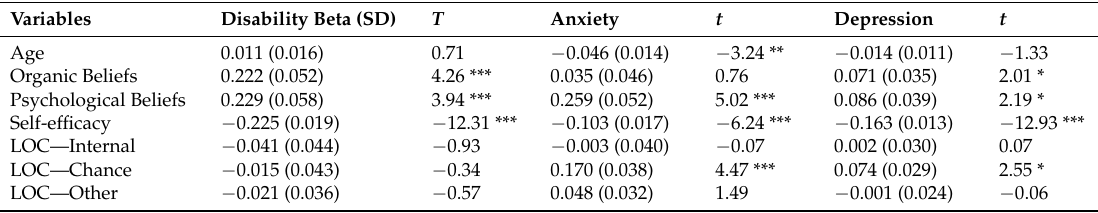
Table 2. Beta (standard deviation) and t -values for Regression